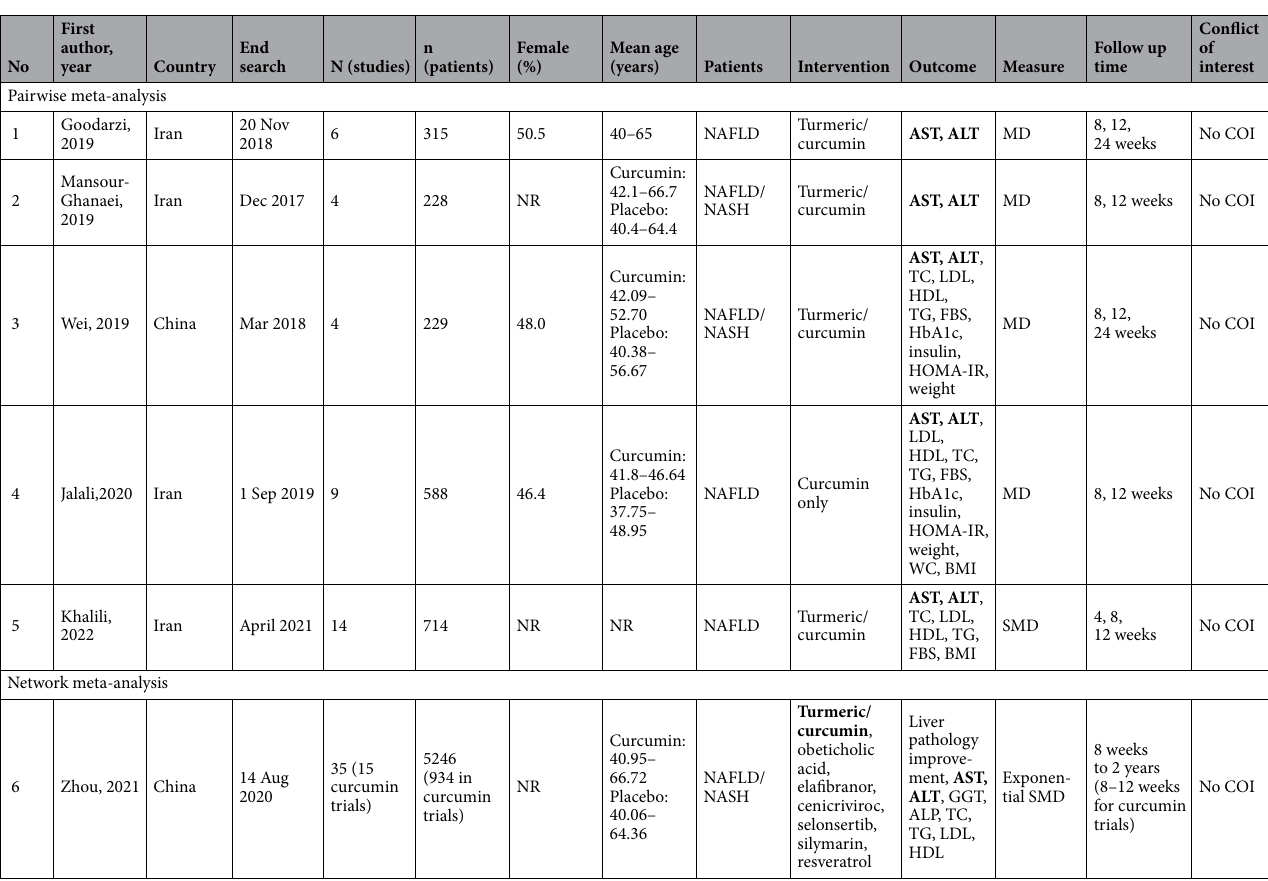
Table 1. Baseline characteristics of systematic reviews and meta-analyses included. ALT alanine aminotransferase, ALP alkaline phosphatase, AST aspartate aminotransferase, BMI body mass index, COI conflict of interest, FBS fasting blood sugar, GGT gamma glutamyl transpeptidase, HbA1c hemoglobin A1c, HDL high-density lipoprotein, HOMA-IR homeostatic model assessment of insulin resistance, LDL low-density lipoprotein, MD mean difference, NAFLD nonalcoholic fatty liver disease, NASH nonalcoholic steatohepatitis, NR not reported, SMD standardized mean difference, TC total cholesterol, TG triglyceride. Significant values are in